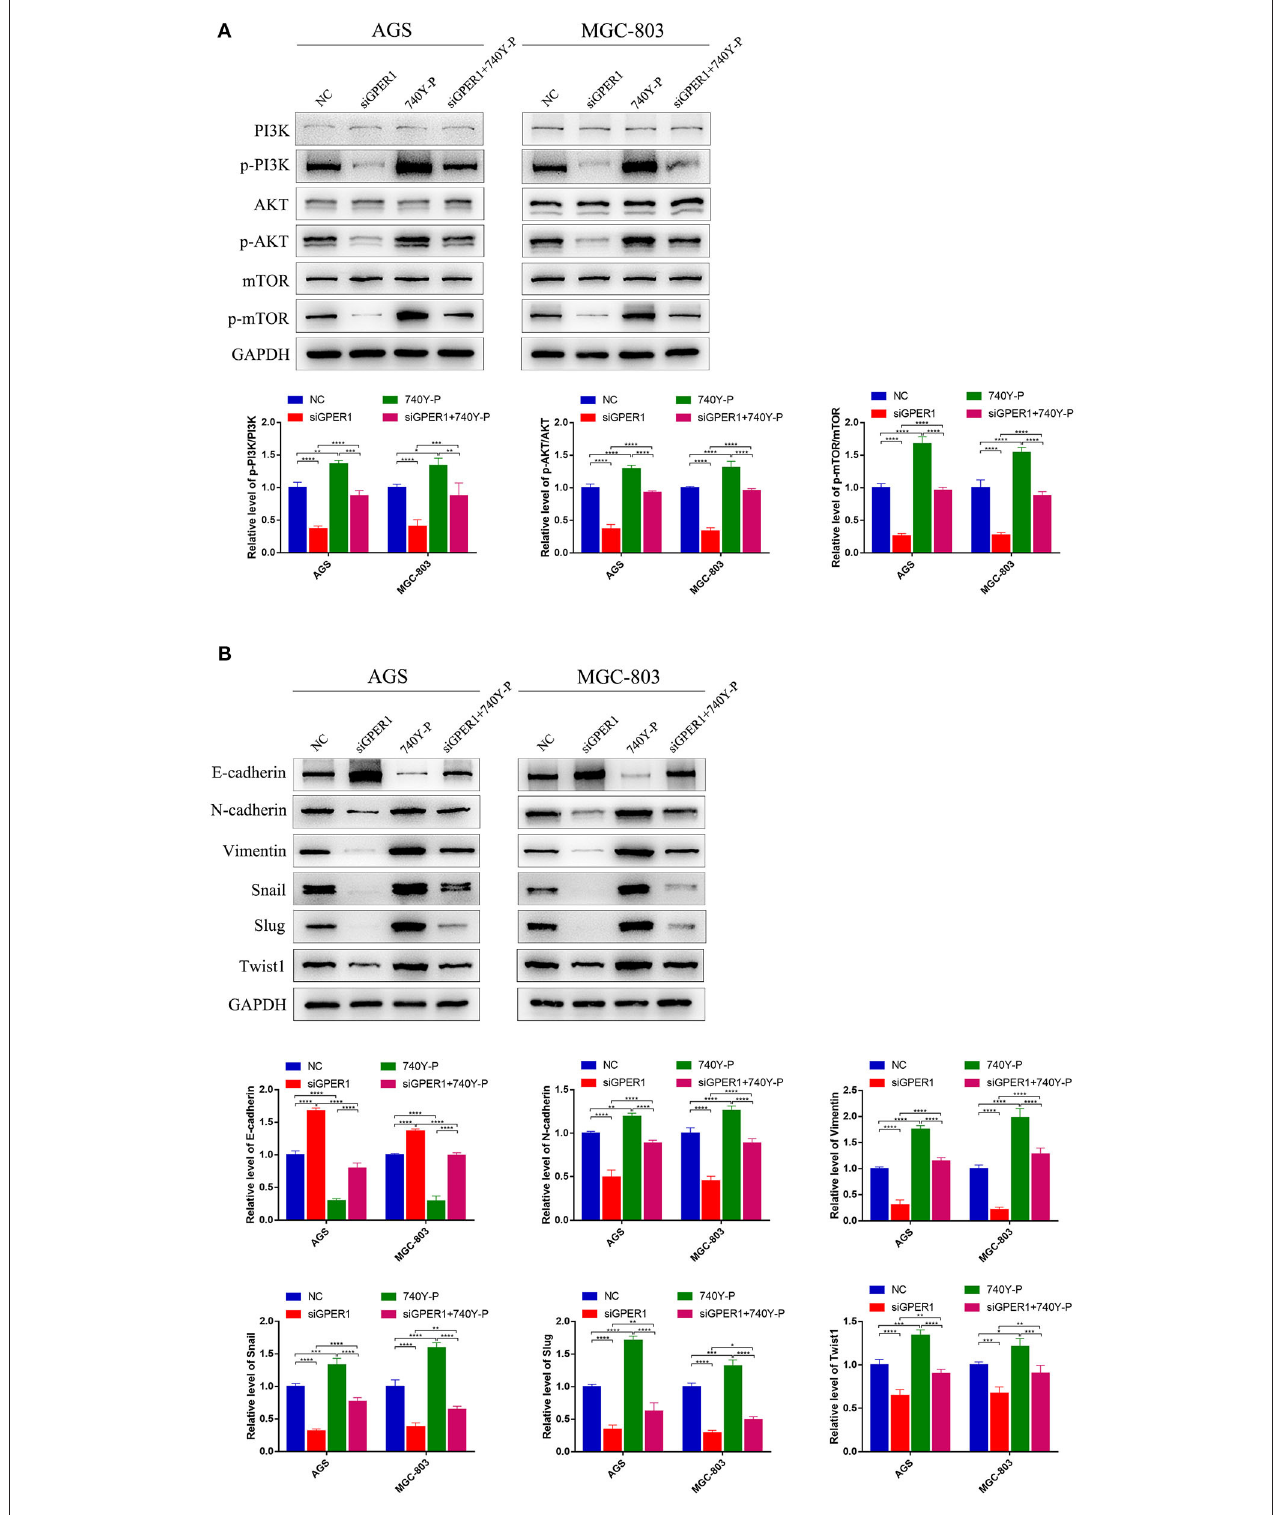
FIGURE 5 | Protein levels of PI3K/AKT and EMT markers in AGS and MGC-803 cells treated with GPER1 siRNA. (A) PI3K/AKT pathway and (B) EMT markers were detected by western blot, GAPDH was evaluated as an internal control. Control, cells without transfection; GPER1, cells transfected with GPER1 siRNA; 740Y-P, cells treated with 740Y-P; GPER1 + 740Y-P, cells transfected GPER1 siRNA and then treated with 740Y-P. Results were shown as mean ± SD of three independent experiments, each experiment was performed in triplicate. * P < 0.05; ** P < 0.01; *** P < 0.001; **** P < 0.0001.